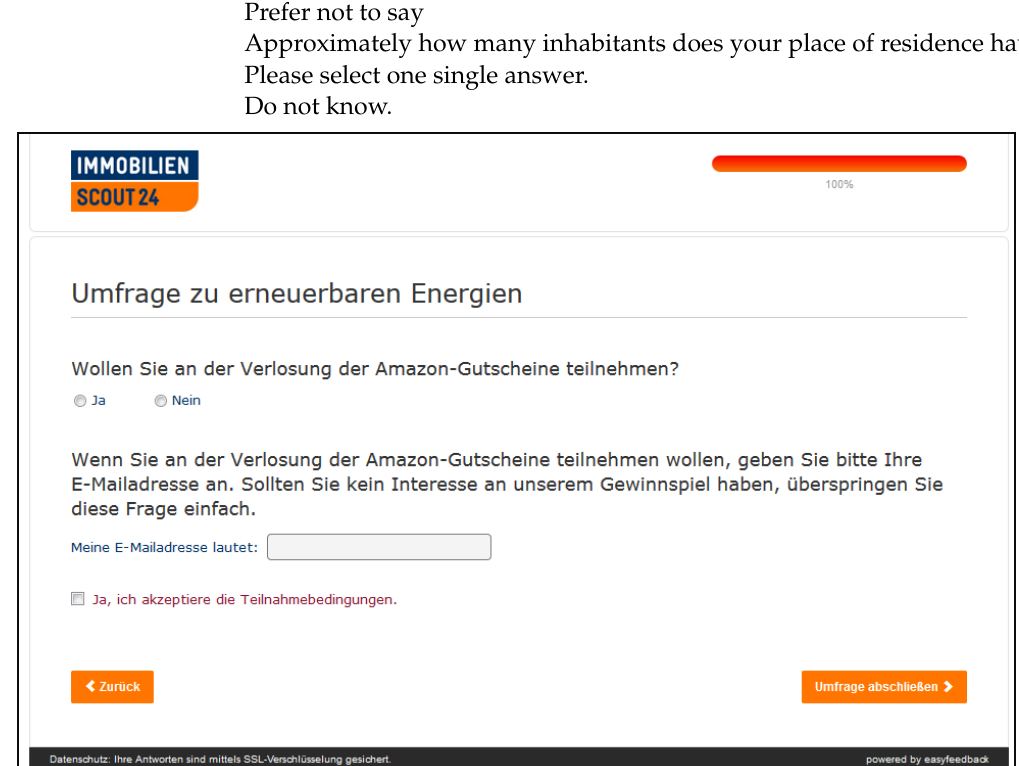
Figure A18. Screenshot of Questionnaire Page 17.